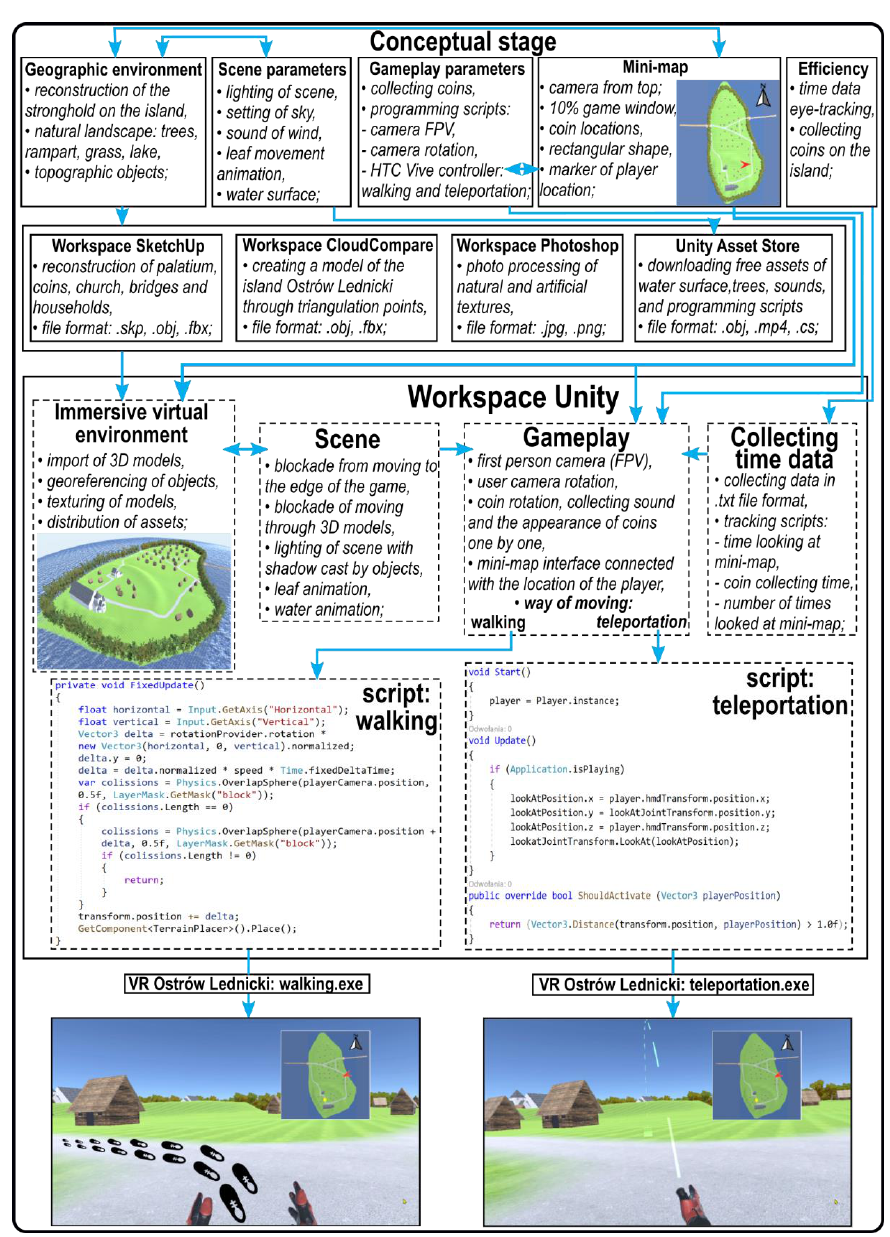
Figure 1 . Scheme of working out the VR application for two game versions: with walking and Figure 1. SchemeofworkingouttheVRapplicationfortwogameversions: teleportation.